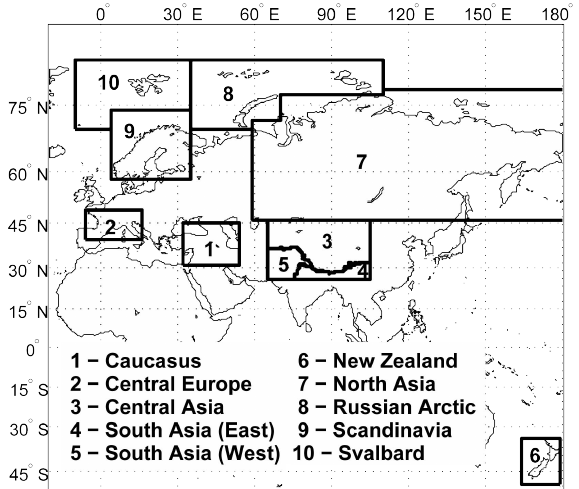
Fig. 2. Locations of the 10 glacierized regions whose glacier distri- butions are presented in Fig. 1 and Table